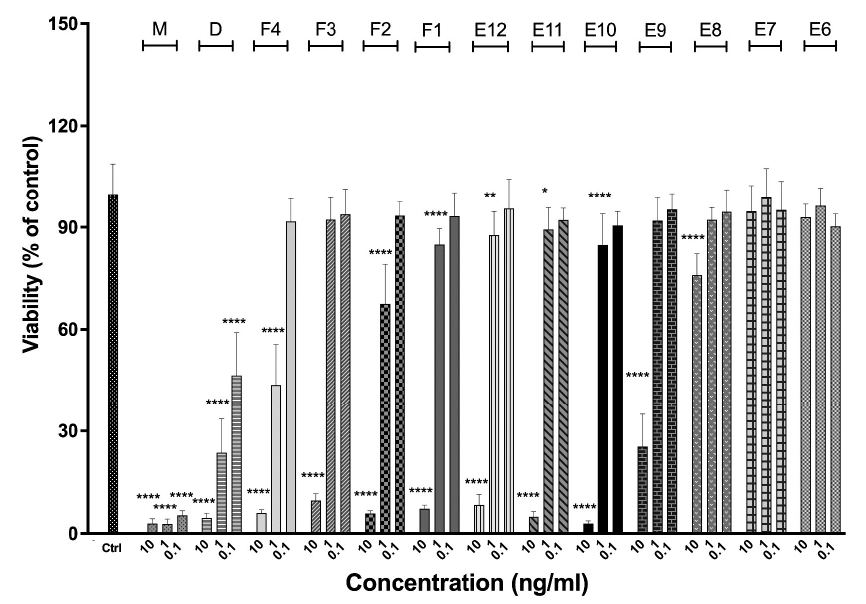
Figure 10. The viability of U-251 glioblastoma cell line in presence of the cytotoxin monomer (M), dimer (D), and oligomers (F4-E6), measured by the MTS assay, in three concentrations, 0.1, 1.0, and 10.0 ng (which correspond to 1.8, 18.1, and 181.3 pM concentration, respectively). Significant differences are indicated as: for * p < 0.05, ** p < 0.01 and **** for p < 0.001.